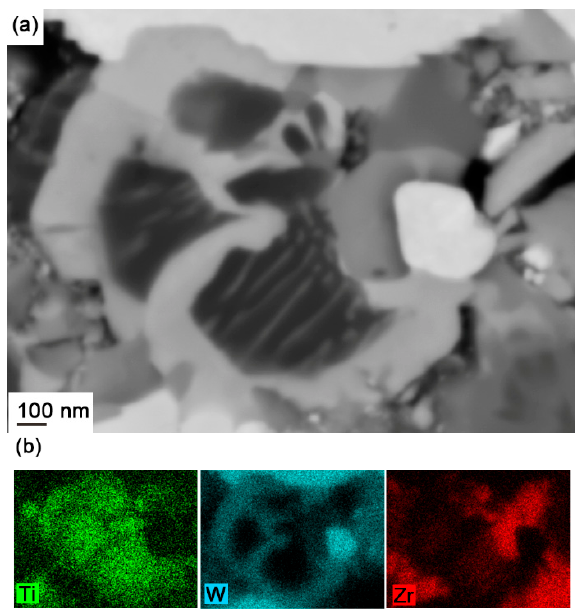
Figure 6. ( a ) SEM backscattered electron micrograph and ( b ) energy dispersive X-ray spectroscopy (EDS) map of cubic carbide phases in composite 1 interruptedly sintered at 1345 °C. Table 2. Concentration of metallic components in the cubic carbide phases at different temperatures, measured by EDS (at %). Undissolved Cubic Carbides Comp.